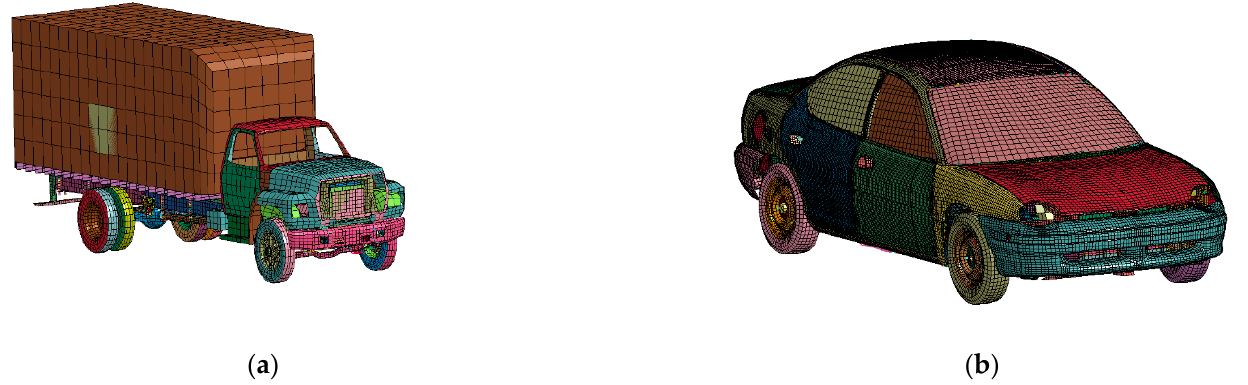
Figure 7. Three-dimensional view of the FE model: ( a ) a Ford single unit truck and ( b ) a Dodge Neon.